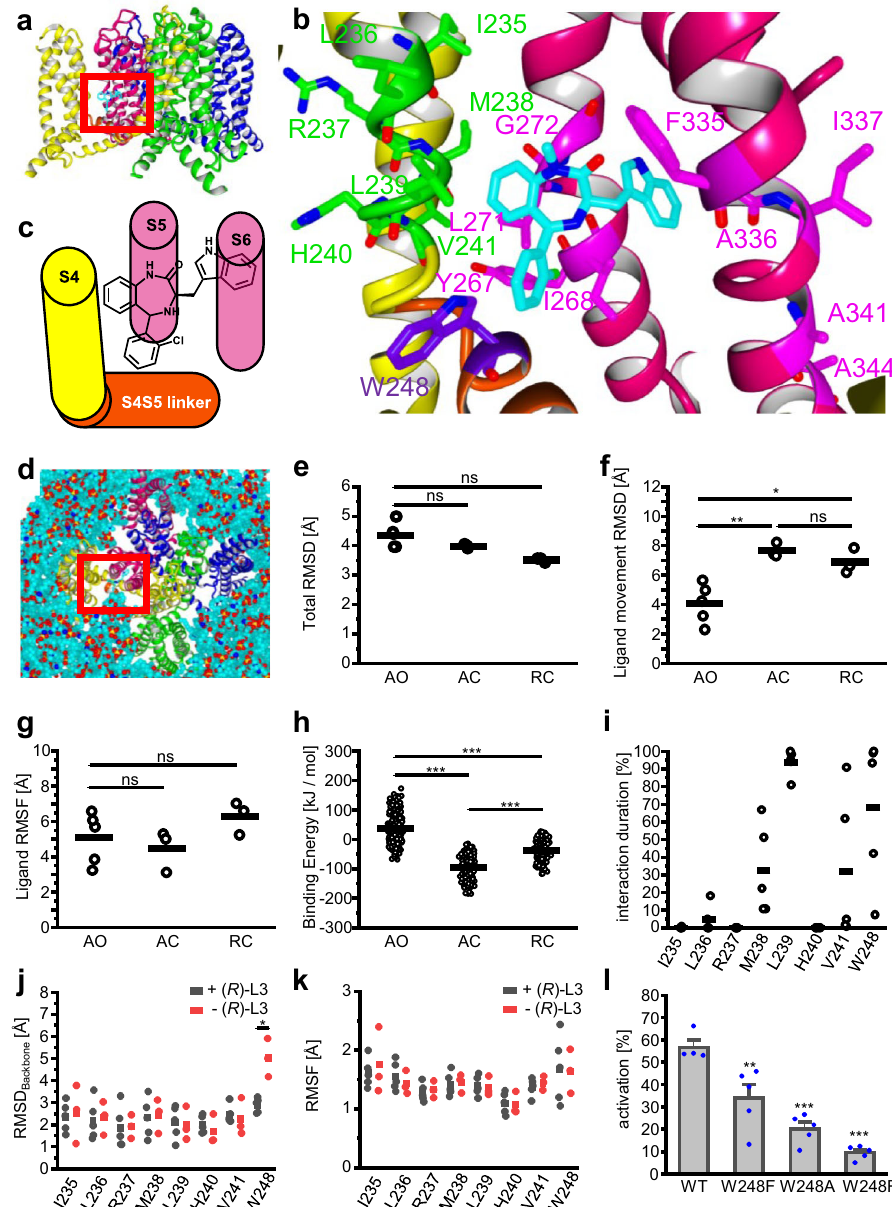
Fig. 6 Binding site localization and in silico simulation results. a Depiction of tetrameric KCNQ1 AO model with subunits colored in magenta (Mol A), yellow (Mol B), green (Mol C) and blue (Mol D). Proposed binding site of ( R )-L3 is marked by red square. b Close-up depiction of ( R )-L3 (CPK-color coded with cyan for carbon) binding site with S4 (yellow) and S4S5 linker (orange) from subunit Mol B and S5 and S6 helix (magenta) from subunit Mol A. Previous analyzed amino acids from S5 and S6 with impact on ( R )-L3 activity are colored in purple, while newly analyzed residues from S4 and S4S5 linker are colored in green or violet. c Schematic illustration of ( R )-L3 binding site between S4 (yellow) and S4S5 linker (orange) from subunit Mol B and S5 and S6 (pink) from subunit Mol A. d Depiction of KCNQ1 AO model embedded in membrane for MD simulation. Subunits Mol A-D are colored like in 5A and ( R )-L3 binding site is marked by red square. e Root mean square deviation (RMSD) of 30 ns MD simulations for complete modeled structures AO (n = 5 simulations), AC ( n = 3) and RC ( n = 3) with ( R )-L3 for every simulation. Means are shown as bar and have no signi fi cant differences indicated by ns. f RMSD of Ligand movement of ( R )-L3 from start to end of the 30 ns MD simulation of KCNQ states AO ( n = 5), AC ( n = 3) and RC ( n = 3). g ( R )-L3 Root mean square fl uctuation (RMSF) for 30 ns MD simulation with KCNQ1 state models AO ( n = 5), AC ( n = 3) and RC ( n = 3). Mean differences are not signi fi cant (ns; p > 0.05). h Binding Energy [kJ/mol] of ( R )-L3 calculated for all simulation snapshots from 10 to 30 ns of MD simulations for KCNQ1 models AO ( n = 405 snapshots), AC ( n = 243) and RC ( n = 243). i Percentage duration of hydrophobic interaction between ( R )-L3 and mutated amino acids from S4 and S4S5 linker over total MD simulation time of 30 ns for AO simulations ( n = 5). j , k Backbone RMSD and RMSF of mutated residues in the absence ( n = 3 simulations)/presence ( n = 5 simulations) of ( R )-L3. l activity of 1 µ M ( R )-L3 at wildtype KCNQ1 expressing oocytes compared to mutations W248F, W248A, and W248R ( n = 4 for WT, n = 5 for W248F, W248A, and W248R).